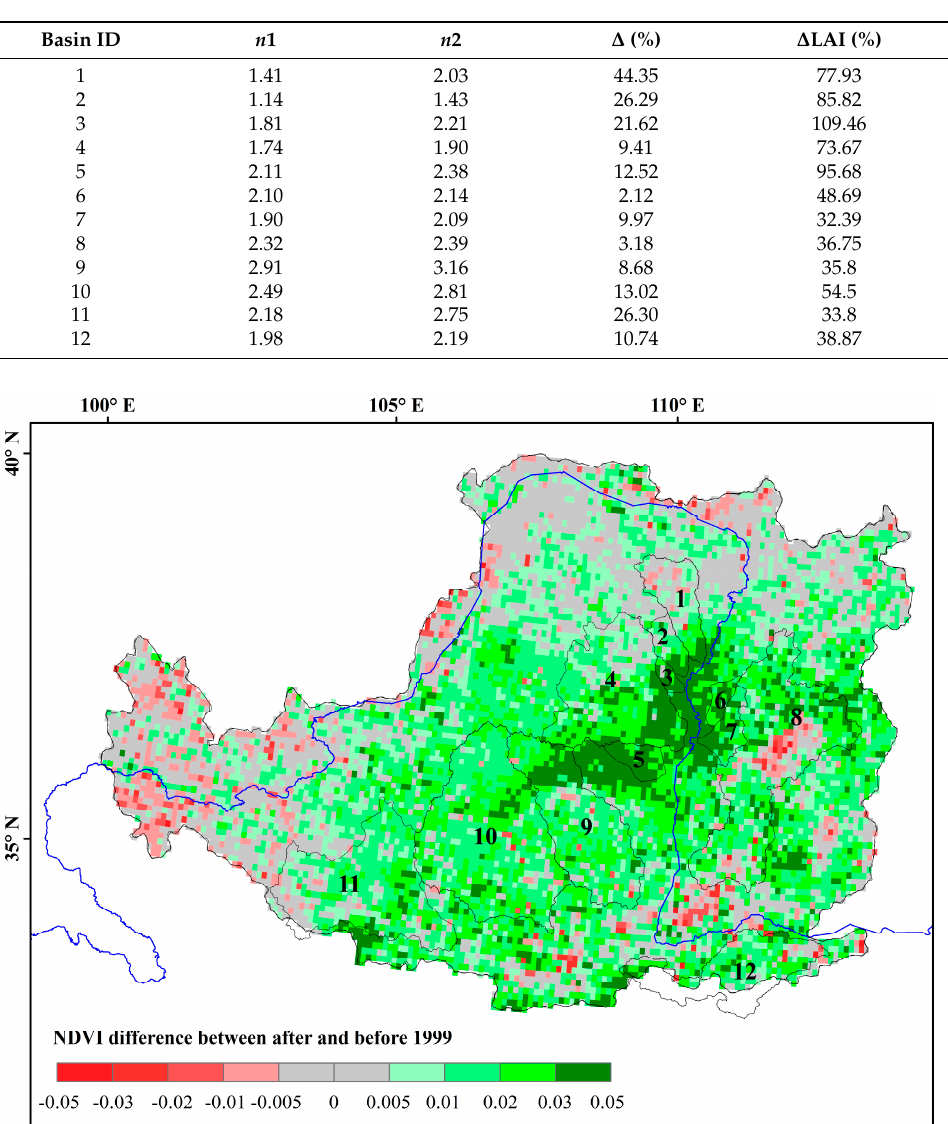
Figure 5. Difference of Normalized Difference Vegetation Index (NDVI) between the two periods in the Loess